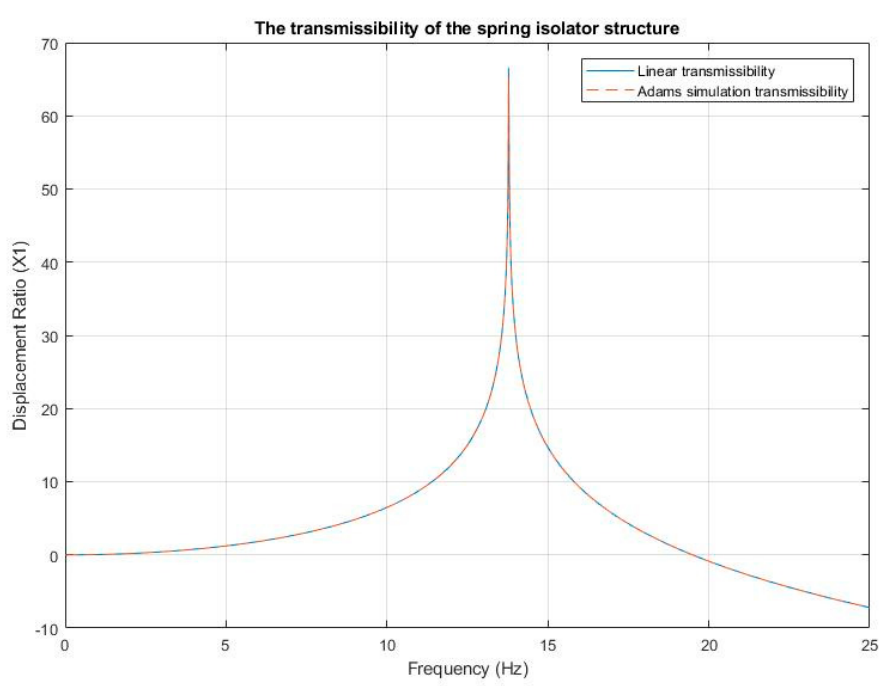
Figure 15. Comparison of transmissibility ratios of the linear spring isolator structure supporting a mass model calculated using analytical method with Matlab code.